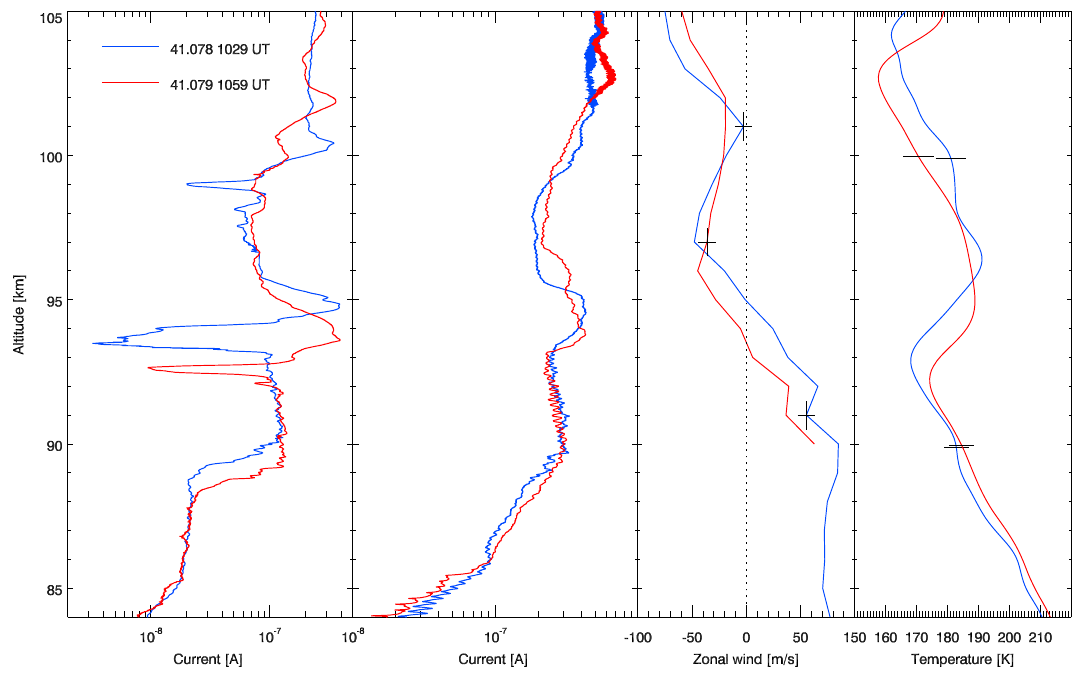
Figure 4. From left to right: nose-tip probe electron currents (ram, upleg), CONE electron probe currents (ram, downleg), zonal winds (upleg), and CONE neutral temperatures (downleg) for missions 41.078 (blue) and 41.079 (red). Typical wind and temperature errors are indicated by black